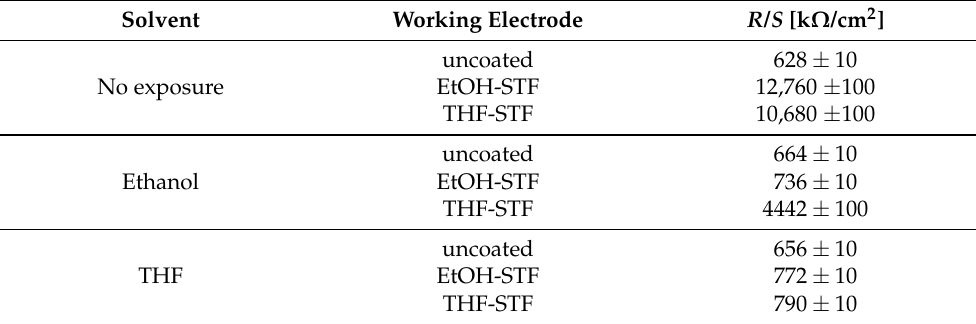
Table 1. Cell resistance measurements per electrode surface area, R / S , of assembled sensor devices using an aqueous lithium carbonate electrolyte. The data show a response to ethanol and THF exposure, as well as the behavior of the non-exposed device. Uncertainties were estimated by repeating the measurements three times. The error of the multimeter used for the CRMs was 0.1%. Solvent Working Electrode R / S [k Ω /cm 2 ] No